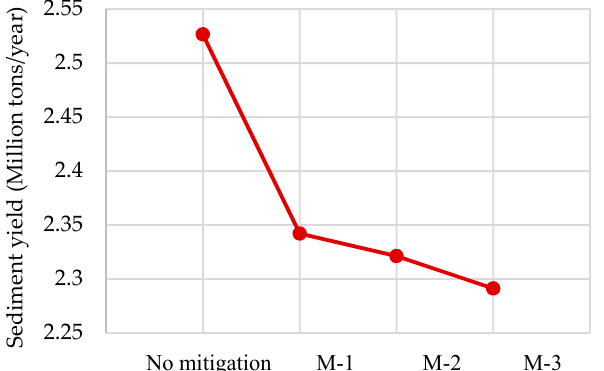
Figure 24. Simulated sediment yield in the case of land cover mitigation in the Hemrin Watershed.